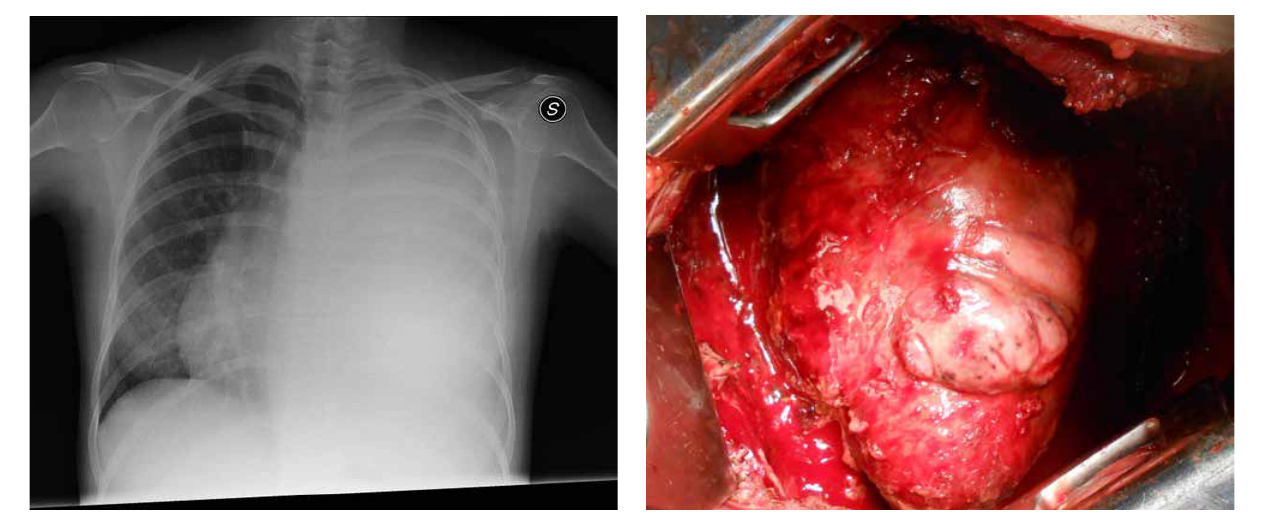
Figure 1: Chest X-ray showing left hemithorax opacification. Figure 4: Unexpandable lung showing after thoracotomy